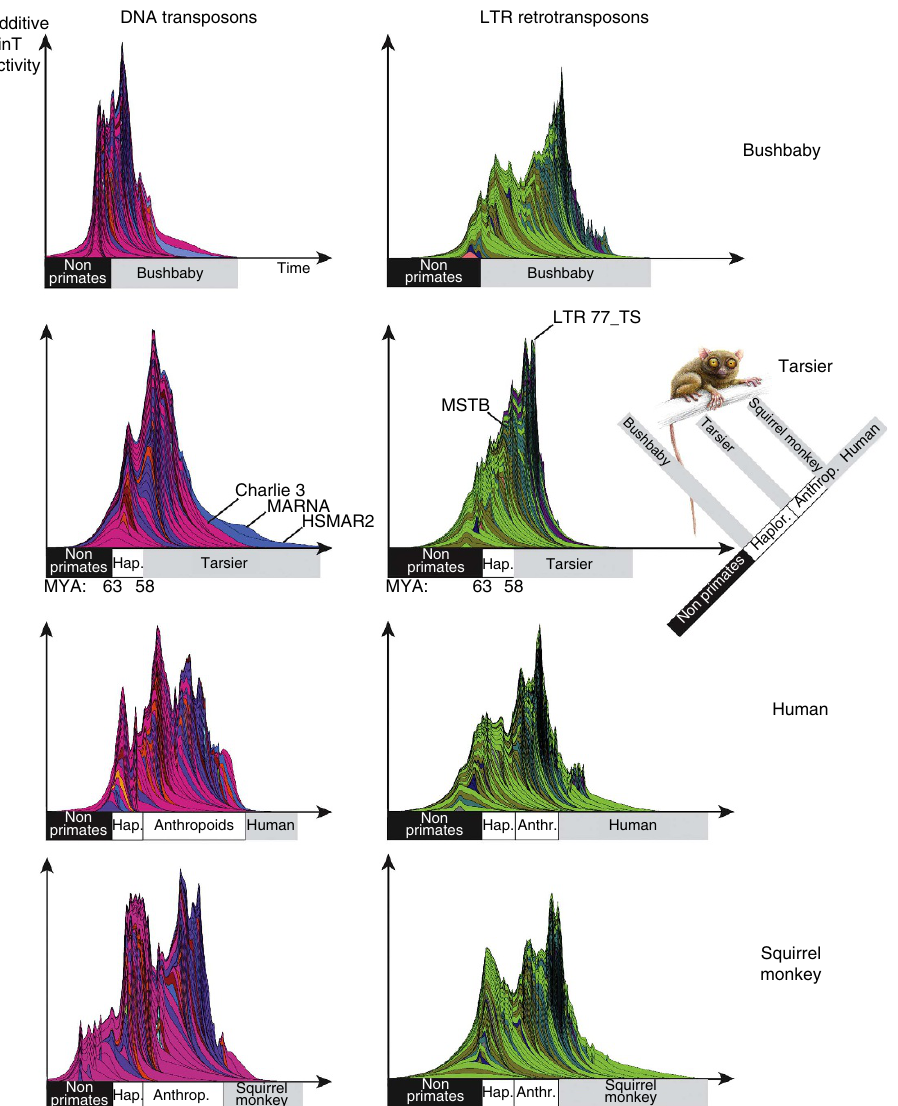
Figure 3 | Cumulative likelihood of activity for DNA transposons and LTR retrotransposons. Cumulative TinTs are shown for bushbaby (Strepsirrhini Otolemur garnettii ), tarsier ( Tarsius syrichta ), human ( Homo sapiens ), and squirrel monkey (New World monkey Saimiri boliviensis ) genomes. Patterns on the left show TinTgenome scans for DNA transposons (red/blue; different layers show different element families), while those on the right depict TinTgenome scans for LTR retrotransposons (green; different layers show different element families). The cumulative non-primate, prosimian-specific and tarsier- specific transposons are indicated below each plot. The bushbaby TinTs represent the earliest divergence of primates. Their DNA transposon cumulative TinT pattern is similar to that of the tarsier. However, the LTR retrotransposons show a somewhat more heterogeneous pattern indicating changes in the population size or changes in LTR activity. In tarsier, the dominating DNA transposons are the Charlie3, MARNA, and HSMAR2 elements, which display recent activity in the tarsier. The ERV MSTB retroposons represented the most informative phylogenetically diagnostic insertions to clearly assign the common ancestor of Haplorrhini, including tarsiers and anthropoids, to a natural phylogenetic group 14 . The LTR77_TS elements were relevant for the transcription and genomic propagation of nearly 30,000 TINE retropseudogenes. The New World, squirrel monkey presents a rugged additive TinTpattern similar to that of human. However, the early anthropoid divergence and distribution of individual New World monkey elements also demand some obvious deviations from the human pattern. Timescales for each pattern run from left to right. The phylogenetic tree to the right indicates the different areas of the cumulative TinTprofiles, separated into (1) non-primates, (2) prosimians and (3) tarsier or human (see also timescale for the first primate split at 63 Mya and the divergence of tarsier at 58 Myr ago). For the principles of the cumulative presentation of TinTpatterns see Fig. 2. Drawings of animals are provided by Jon Baldur Hlioberg. Drawing of Tarsiiformes has been reproduced from Hartig et al. 14 with